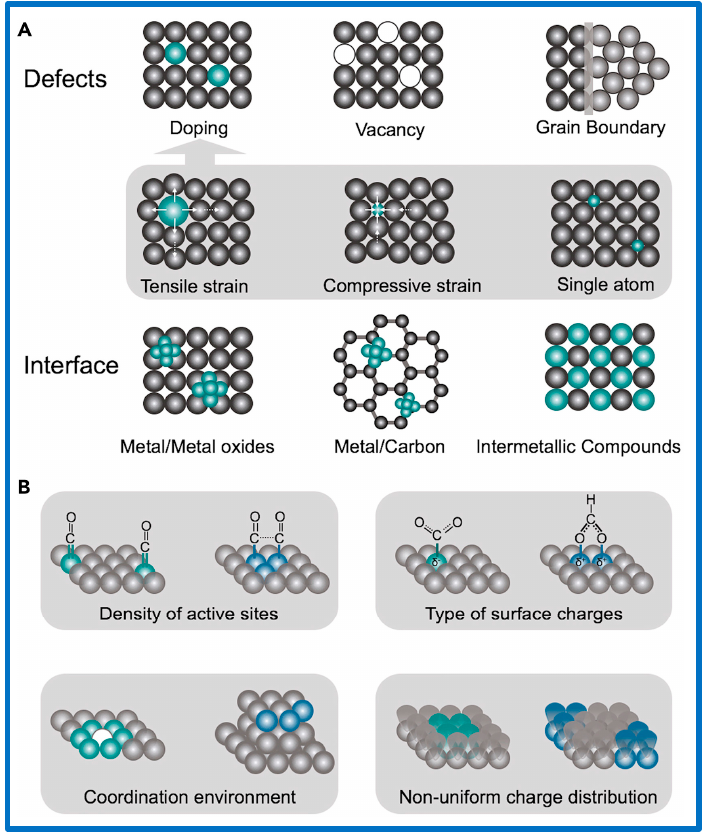
Figure 5. Representation of various defect/interface designs on the electrocatalyst surface ( A ) and illustration of the effects of these defects/interfaces on the electrocatalyst surface for the CO 2 -RR ( B ) [68] (copyright: Cell Press, 2018).